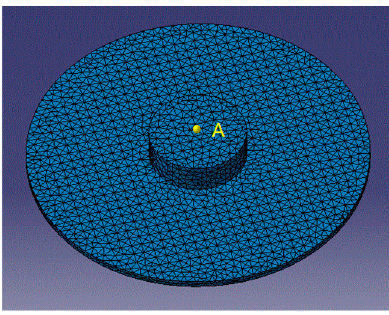
Figure 9. Field point A in fluid.